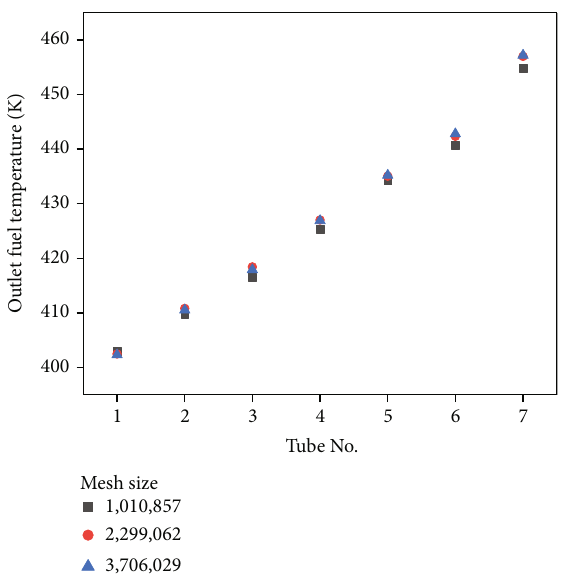
Figure 5: Outlet fuel temperature with di ff erent AR